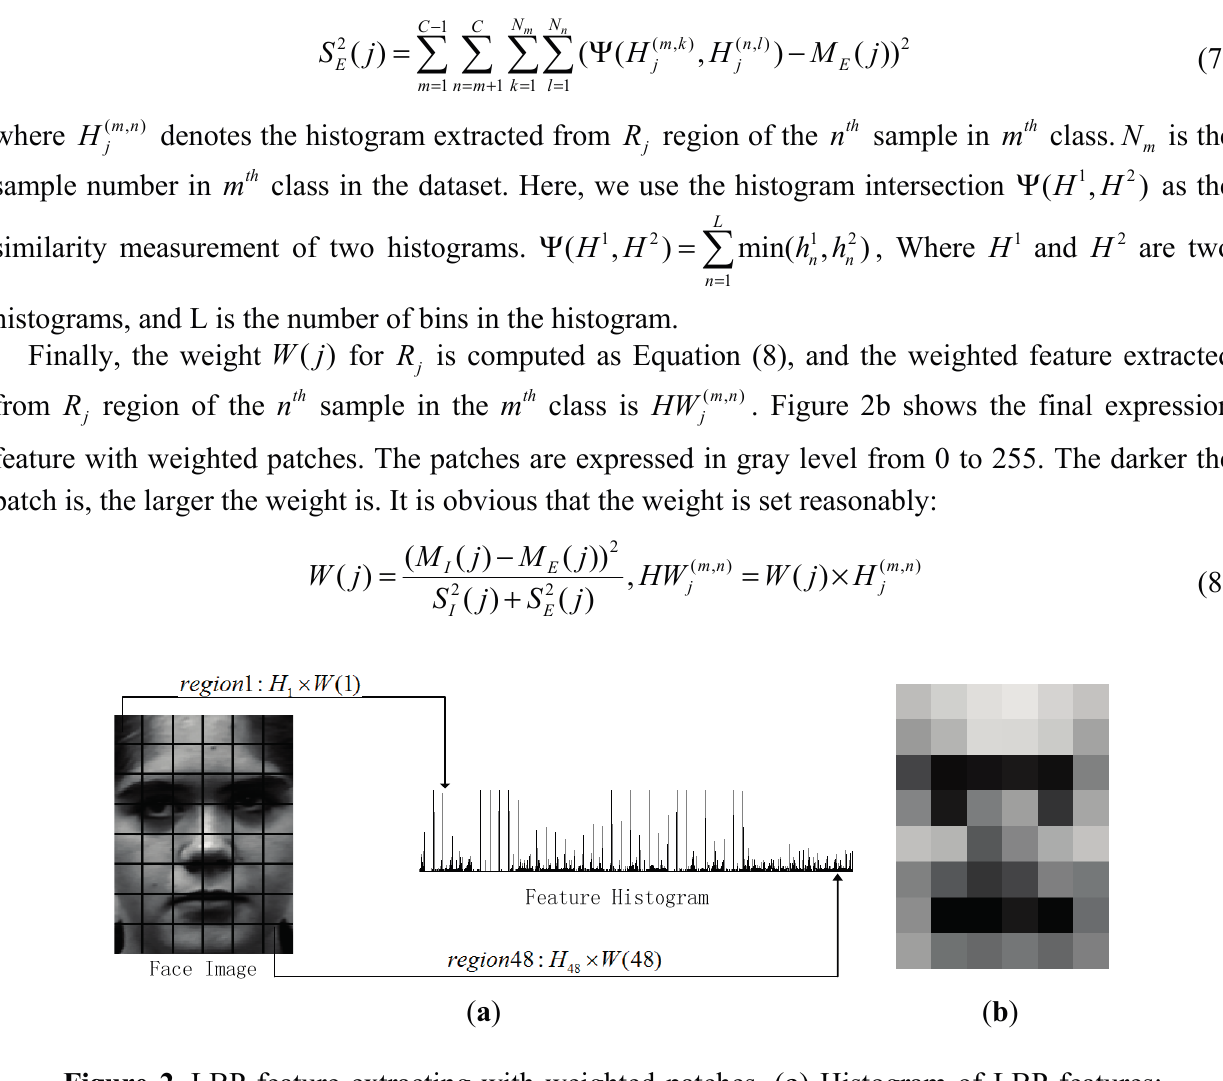
Figure 2. LBP feature extracting with weighted patches. ( a ) Histogram of LBP features; ( b ) Weighted